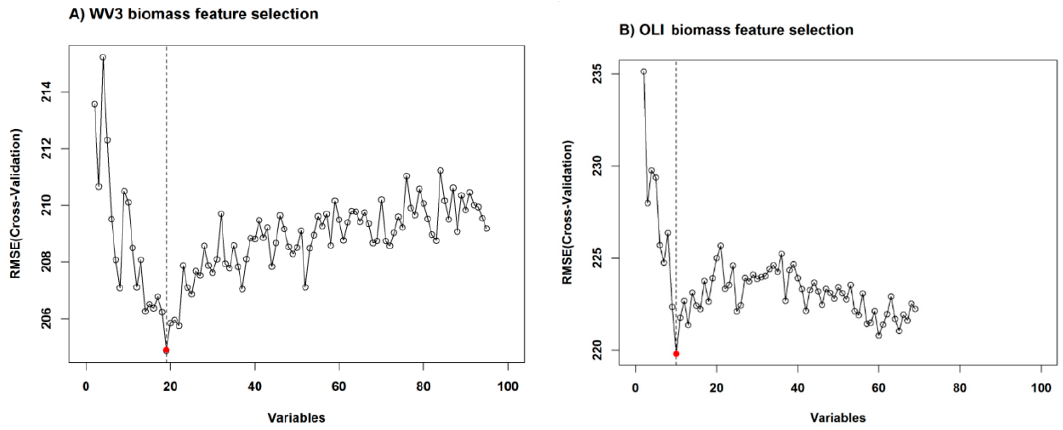
Figure 7. Biomass model recursive feature elimination (RFE) for ( A ) WV3 and ( B ) OLI sensor types and all predictor variables indicating the optimum number of predictors (red dot) used in each final Random Forest regression tree model. Selected features were used to develop final Random Forest biomass models using a reduced set of optimized predictors for each sensor type.